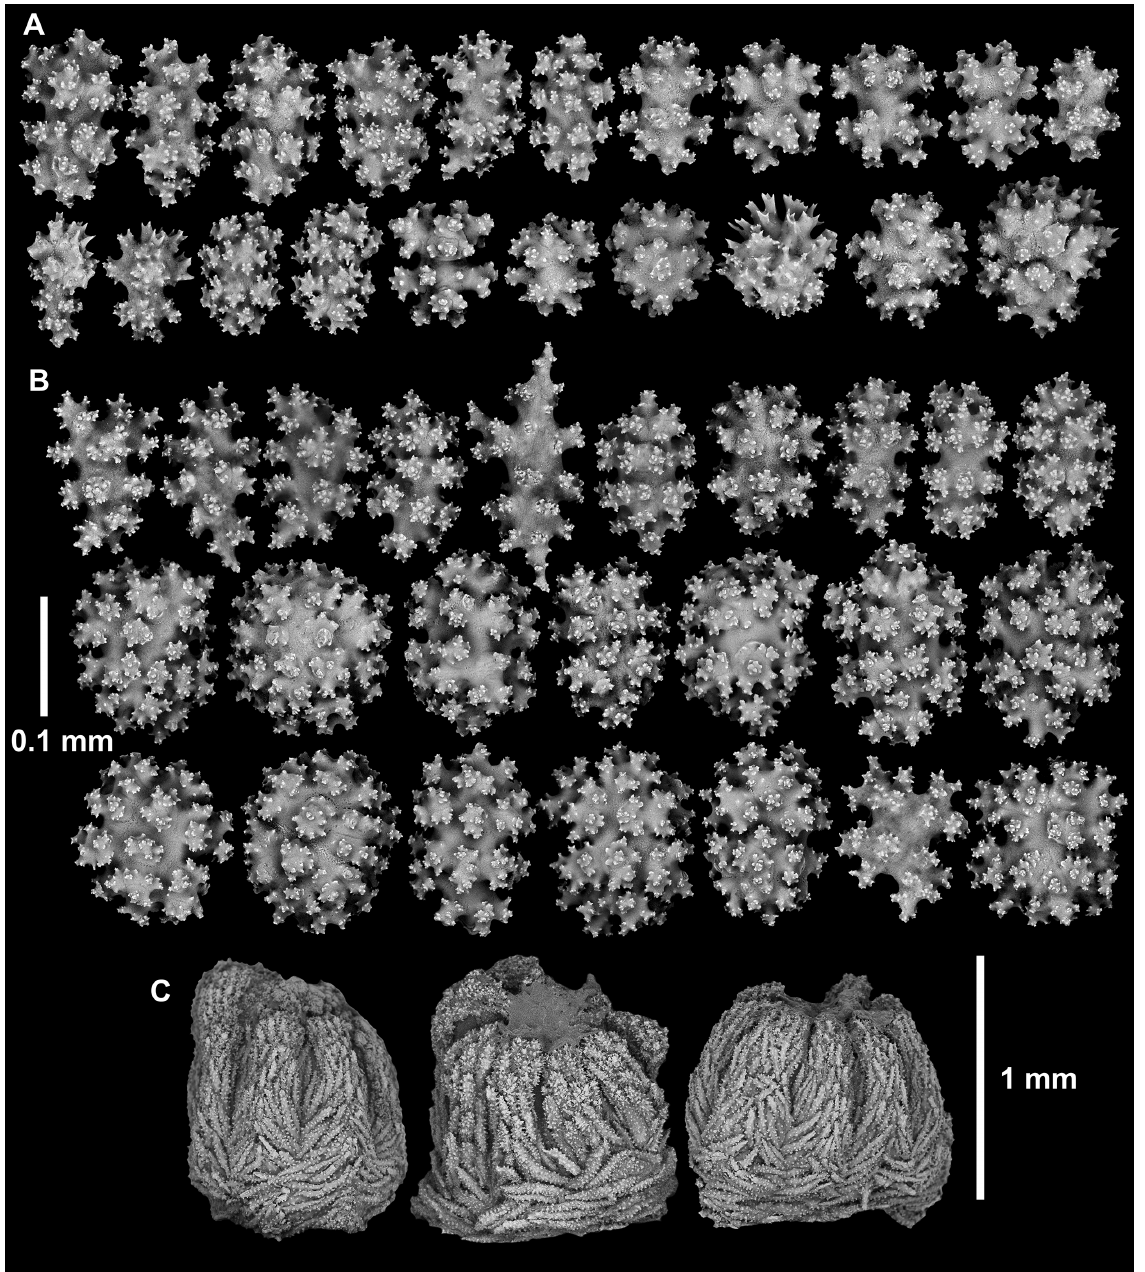
Fig. 17. Kotatea kurakootingotingo gen. et sp. nov., holotype (NIWA 101538), SEMs of sclerites. A . Base surface. B . Base interior. C . Polyps (in